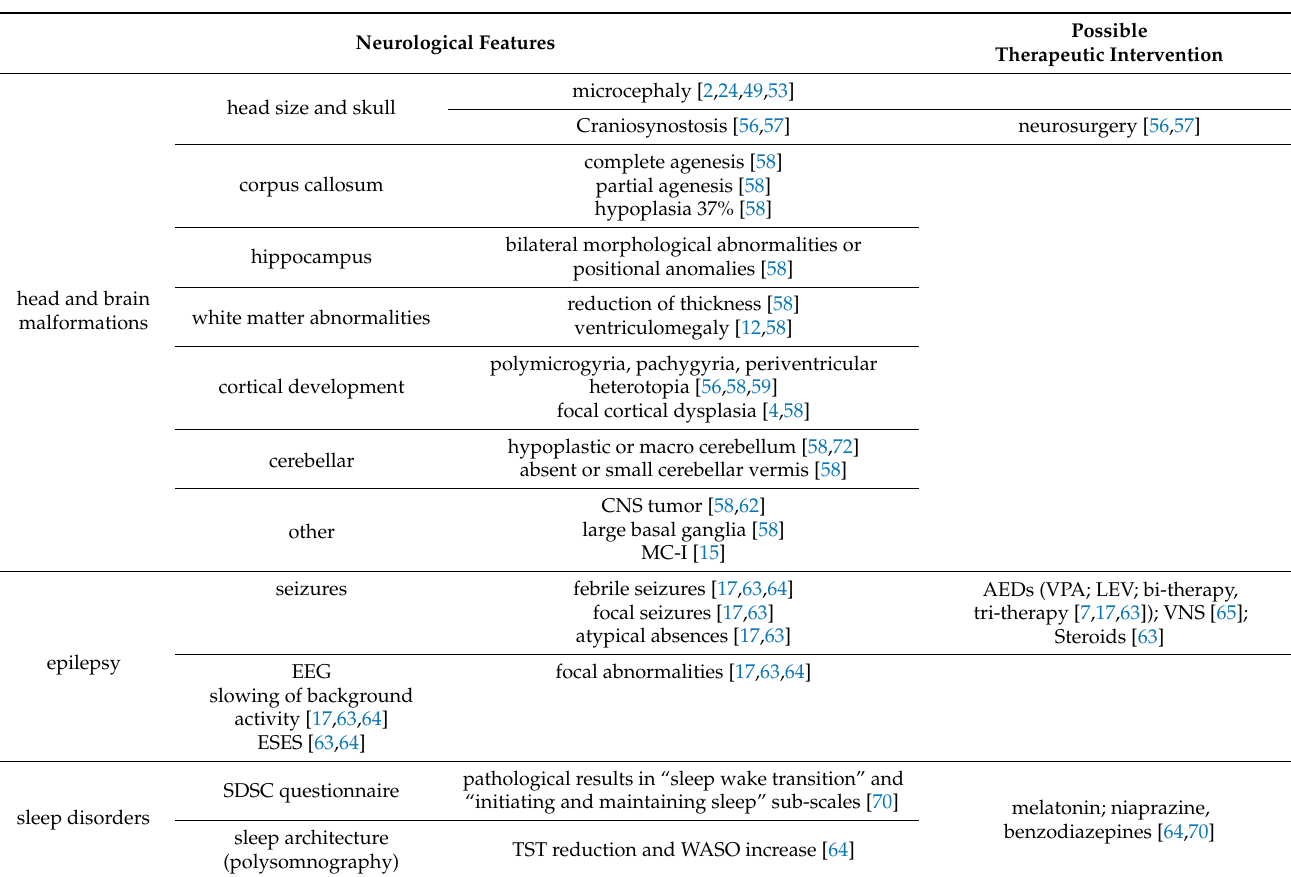
Table 1. Table 1. Main neurological features in Mowat-Wilson